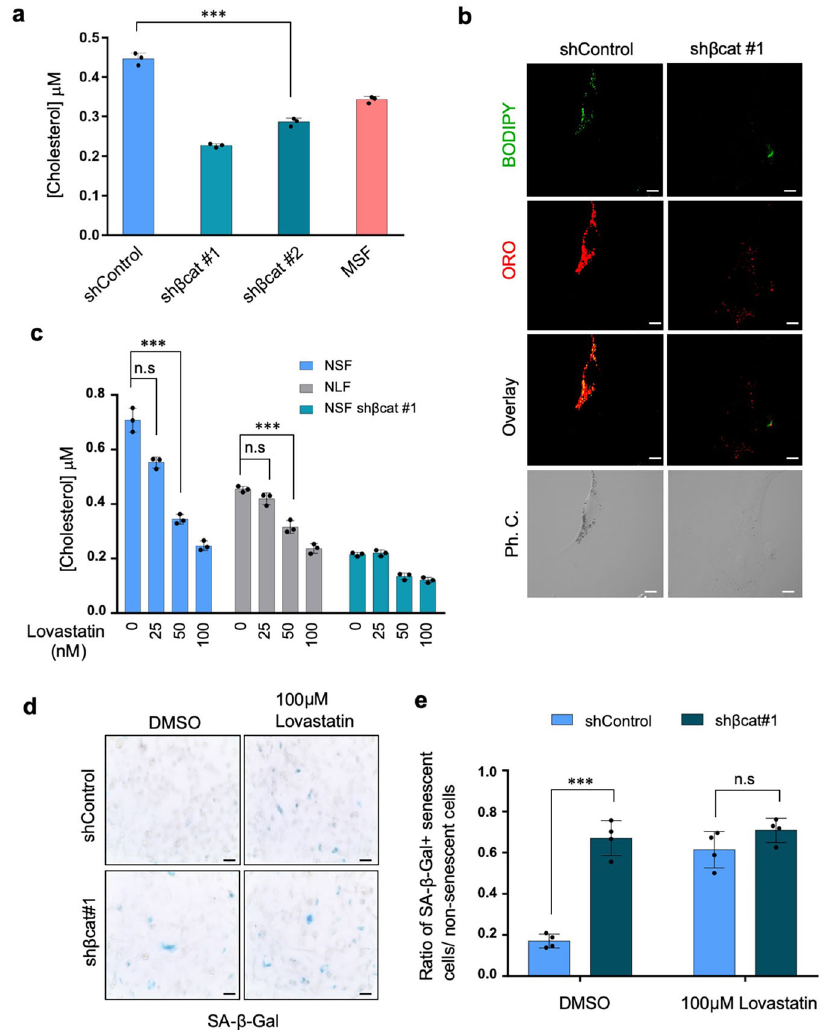
Fig. 4 Association between senescence-like phenotypes and accumulation of cholesterol-enriched lipid droplets. a Cholesterol assay demonstrating that β -catenin knockdown decreases the cholesterol concentration. b Representative confocal images showing staining of cholesteryl ester by BODIPY C12 in NSF shControl and sh β -catenin cells, with or without serum. Scale bar, 20 μ m. c The cholesterol concentration was decreased by lovastatin treatment in a dose-dependent manner. Data are expressed as the mean ± standard deviation ( n = 3 biologically independent experiments); *** P < 0.001, two-sided Student ’ s t test. d Representative bright- fi eld images showing that inhibition of cholesterol synthesis in NSFs increases SA- β -gal activity. e Quantitative analysis of SA- β -Gal-stained cells in control and β -catenin knockdown NSFs. Data are expressed as the mean ± ± standard deviation ( n = 4 biologically independent experiments); *** P < 0.001, two-sided Student ’ s t